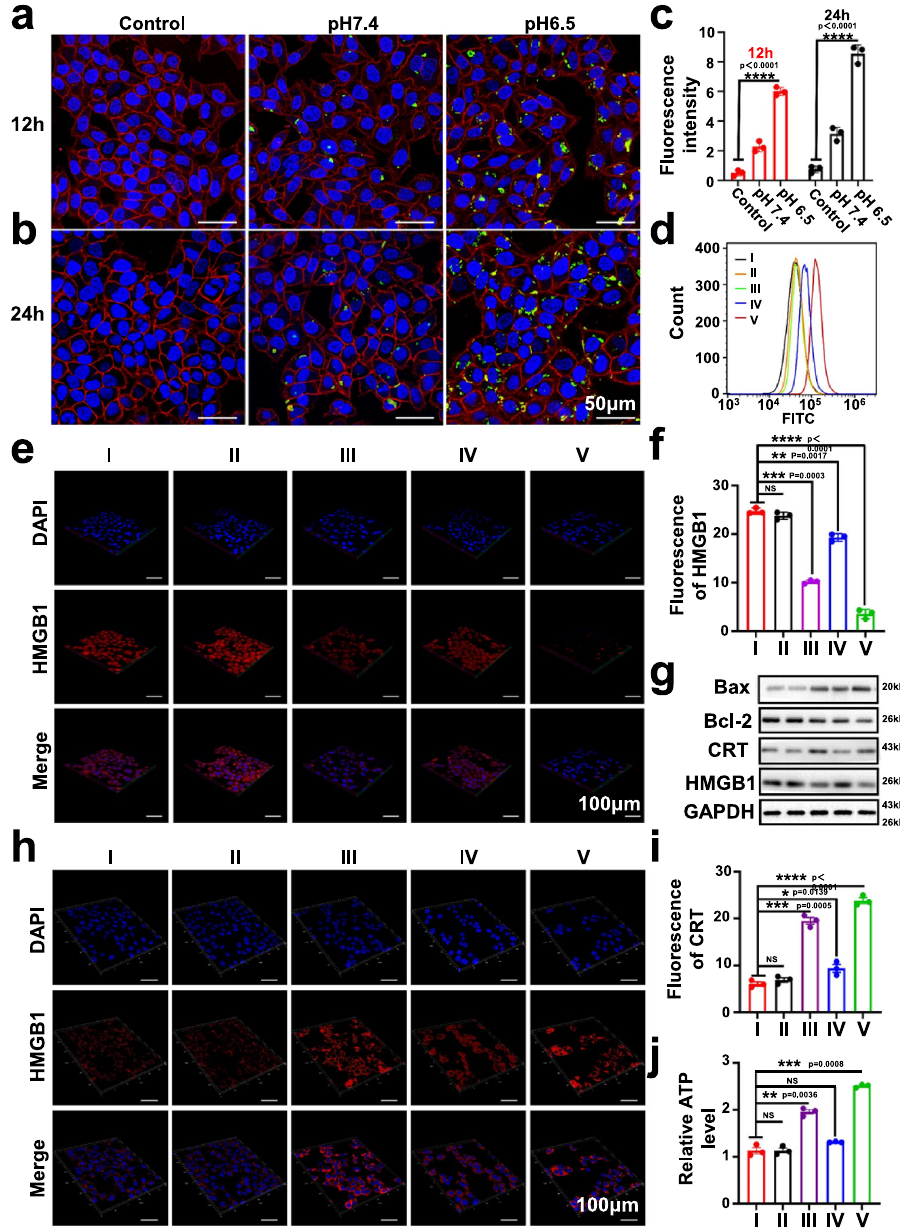
Fig. 3 | BSA-Man@Mn 2+ -Ft@Lap nanoassembly induced immunogenic apop- tosis oftumorcells via Lap-mediatedchemotherapy.a , b Fluorescenceimaging on the endocytosis of BSA-Man@Mn 2+ -Ft-FITC@Lap by 4T1 tumor cells after incubation under different pH values for 12h and 24h. c Quantitative analysis of FITC fl uorescence from panel a/b. d Flow cytometric analysis regarding the accu- mulationofmannose-modi fi edBSAcontentsinDCsafter24hofincubationwith(I) control, (II) BSA-FITC@Mn 2+ -Ft@Lap at pH 7.4, (III) BSA-FITC-Man@Mn 2+ -Ft@Lap treatment with (I) control, (II) BSA-Man-Ft, (III) BSA-Man-Ft@Lap, (IV) BSA- Man@Mn 2+ -Ft,and(V)BSA-Man@Mn 2+ -Ft@Lap.Greaterred fl uorescenceindicates lower HMGB1 release. f Quantitative fl uorescence analysis of HMGB1 release in panel ( e ). g Western blot analysis on the expression levels of HMGB1, CRT and apoptosis markers (Bax, Bcl-2) in 4T1 cells with different treatments. h CLSM